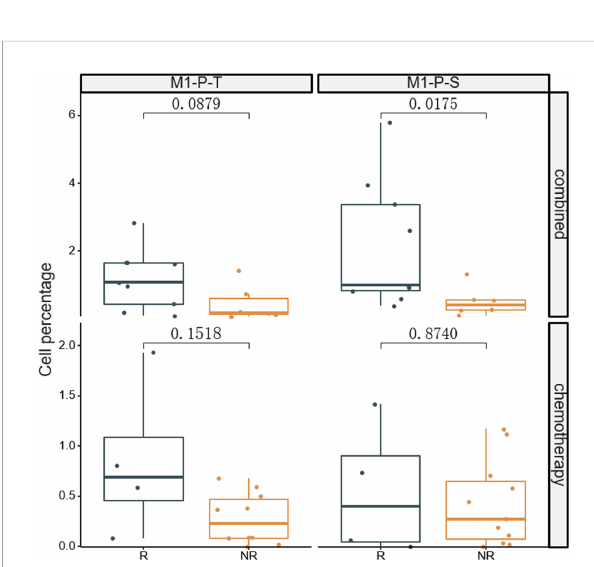
FIGURE 2 Comparison of densities of M1 macrophages and CD56 dim NK cells in the stromal zone between responders and non-responders the signi fi cance level of M1 macrophages and CD56dim NK cells from baseline between the two groups were compared. R, responder; nR, non-responder; Combined, immunochemotherapy; D, density; S, stroma region; M1, CD68 + CD163 - macrophage; M2, CD68 + CD163 + macrophage; P < 0.05, Signi fi cant difference.